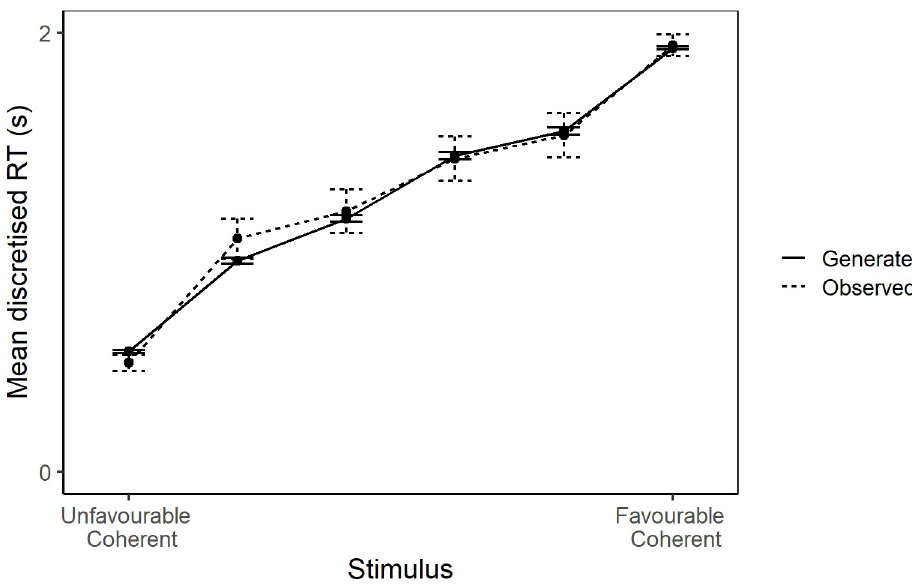
Fig 2. Observed vs. generated reaction time data. The mean discretised reaction time for each stimulus level for both the model-generated and observed judgement bias data. Error bars represent one standard